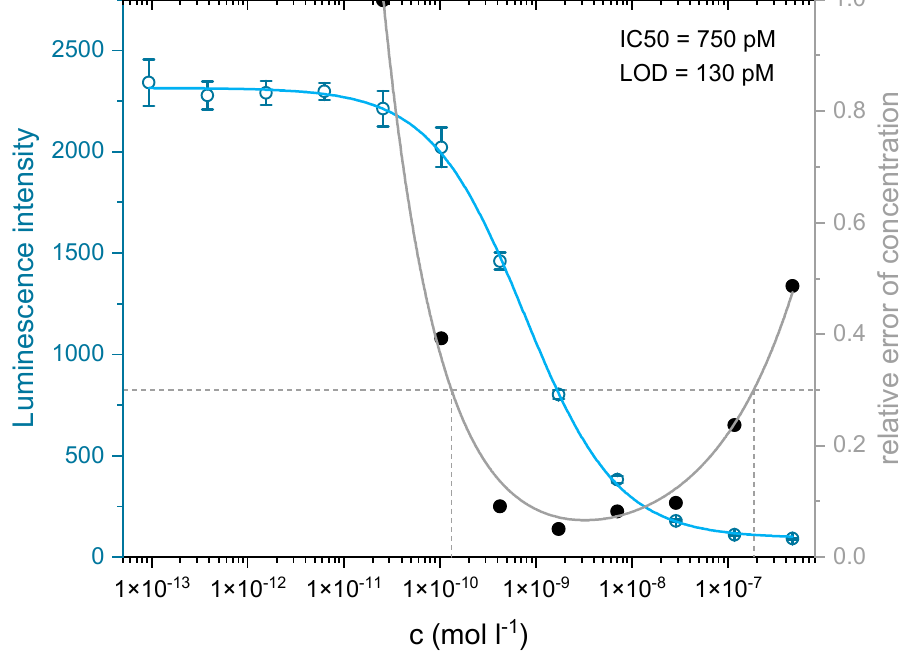
Figure 6. An indirect competitive ELISA and precision profile (black dots, grey line) for the clone IP3G2. The IC50 was determined to be 750 pM, and a working range of 130 pM to 190 nM was obtained.